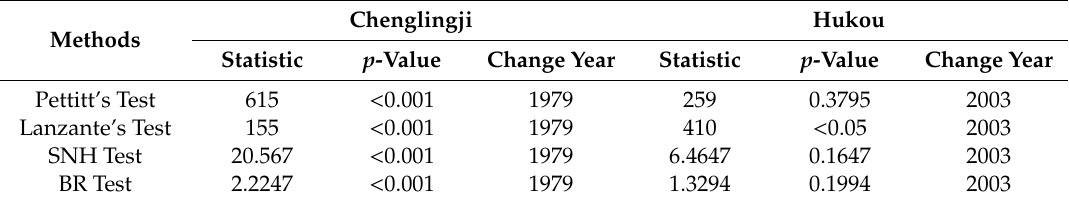
Table 3. Detection of change year from four statistical